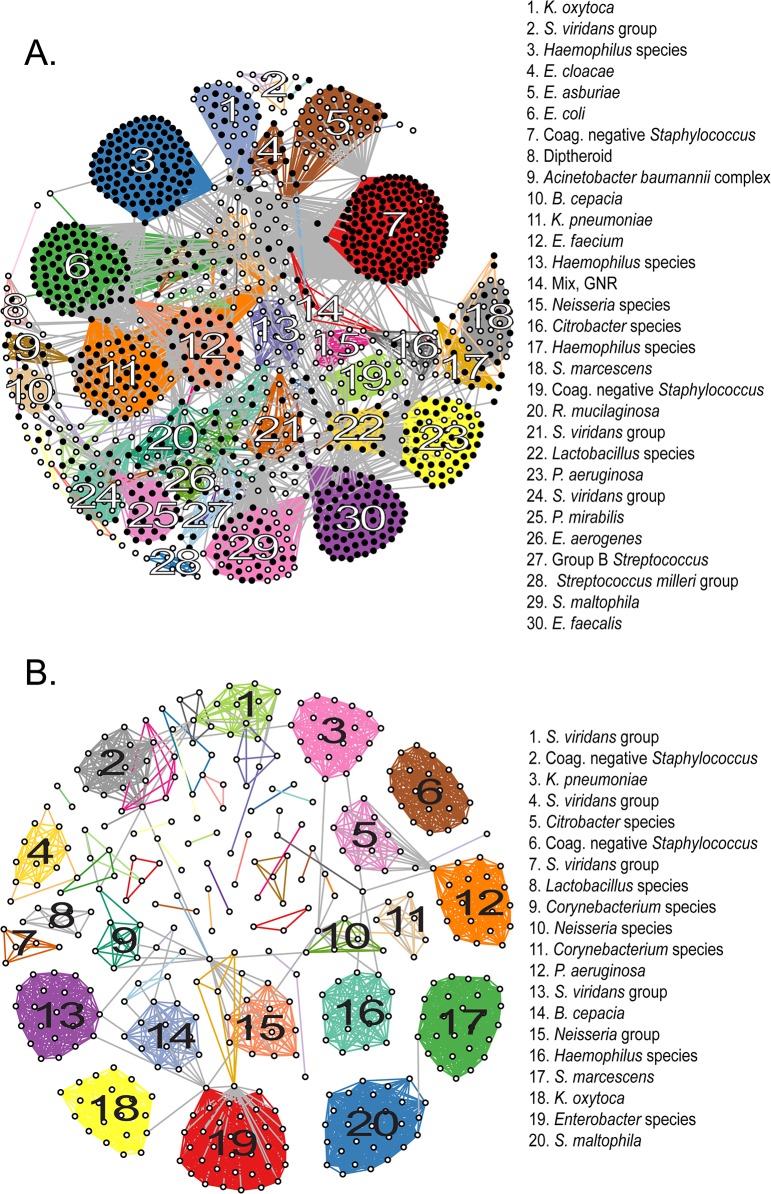
Clustering of sequenced isolates by genomic similarity.(A) Network diagram of all 1,229 sequenced isolates that could be assigned to one of 78 clusters on the basis of pairwise ANIb. Each node represents an individual isolate, and is colored black if robustly matching a previously reported genome (≥ 95% ANIb) or white if corresponding to a novel genomospecies. Nodes connected by a visible edge indicate pairwise ANIb values ≥ 95%. Edges connecting isolates within the same cluster are colored according to that cluster, edges connecting isolates that match multiple clusters are grey. Clusters are labeled according to the most detailed taxonomic classification given to isolates during conventional identification. (B) Network diagram of 419 isolates corresponding to novel genomospecies, assigned to 53 clusters on the basis of pairwise ANIb. Clusters are labeled as in (A). For both panels, the length of edges between nodes is not informative or proportional to ANIb values, and consequently neither is the placement of specific nodes or groups within the graph. The amount of connectivity among nodes indicates the basis of their inclusion with respect to specific groups.